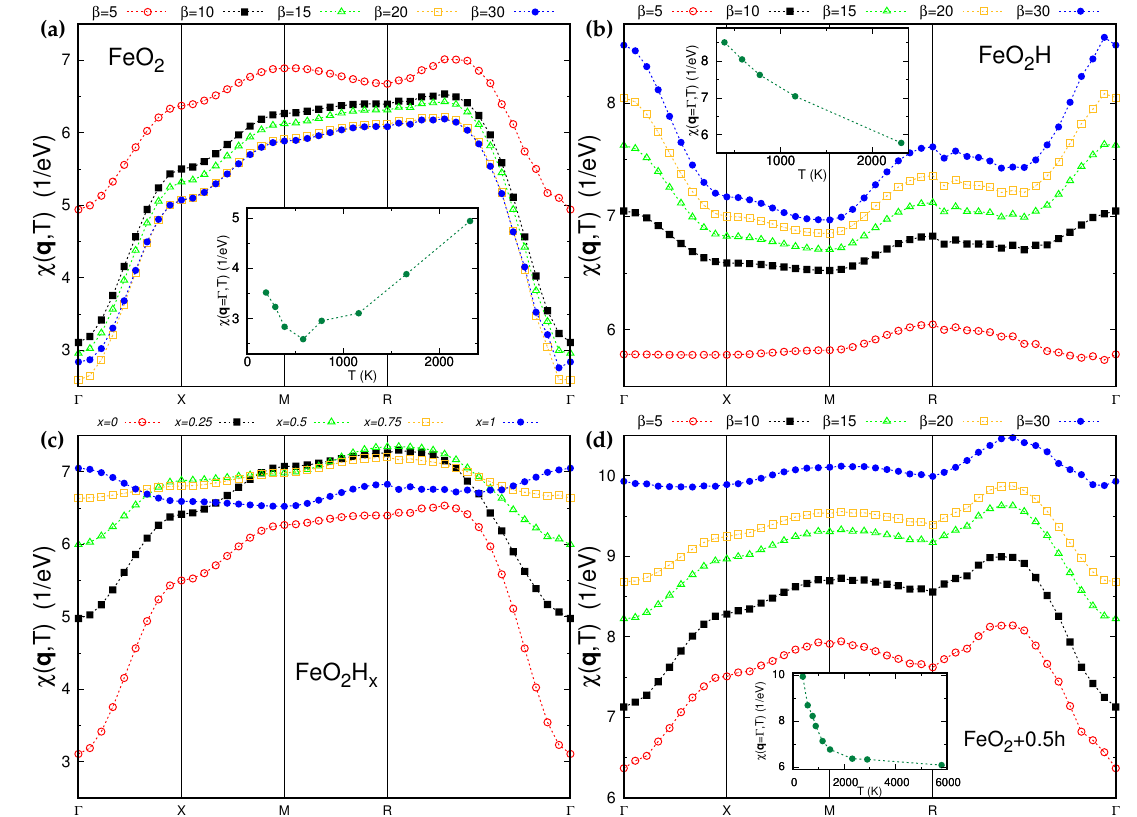
Figure 4. (Color online) The momentum-resolved spin susceptibility, χ ( q , T ) , computed according to Equation (2) along the high symmetry directions of the Brillouin zone for different inverse temperatures. The insets show the temperature dependence of the corresponding susceptibility at the Γ point. ( a ) The temperature dependence of χ ( q , T ) for pure FeO 2 , ( b ) the temperature dependence of χ ( q , T ) for completely hydrogenated FeO 2 H, ( c ) χ ( q , β = 10 ) as a function of hydrogen concentration in FeO 2 H x , ( d ) the temperature dependence of χ ( q , T ) for 0.5 hole doped FeO 2 . For the color coding, please see the figure’s